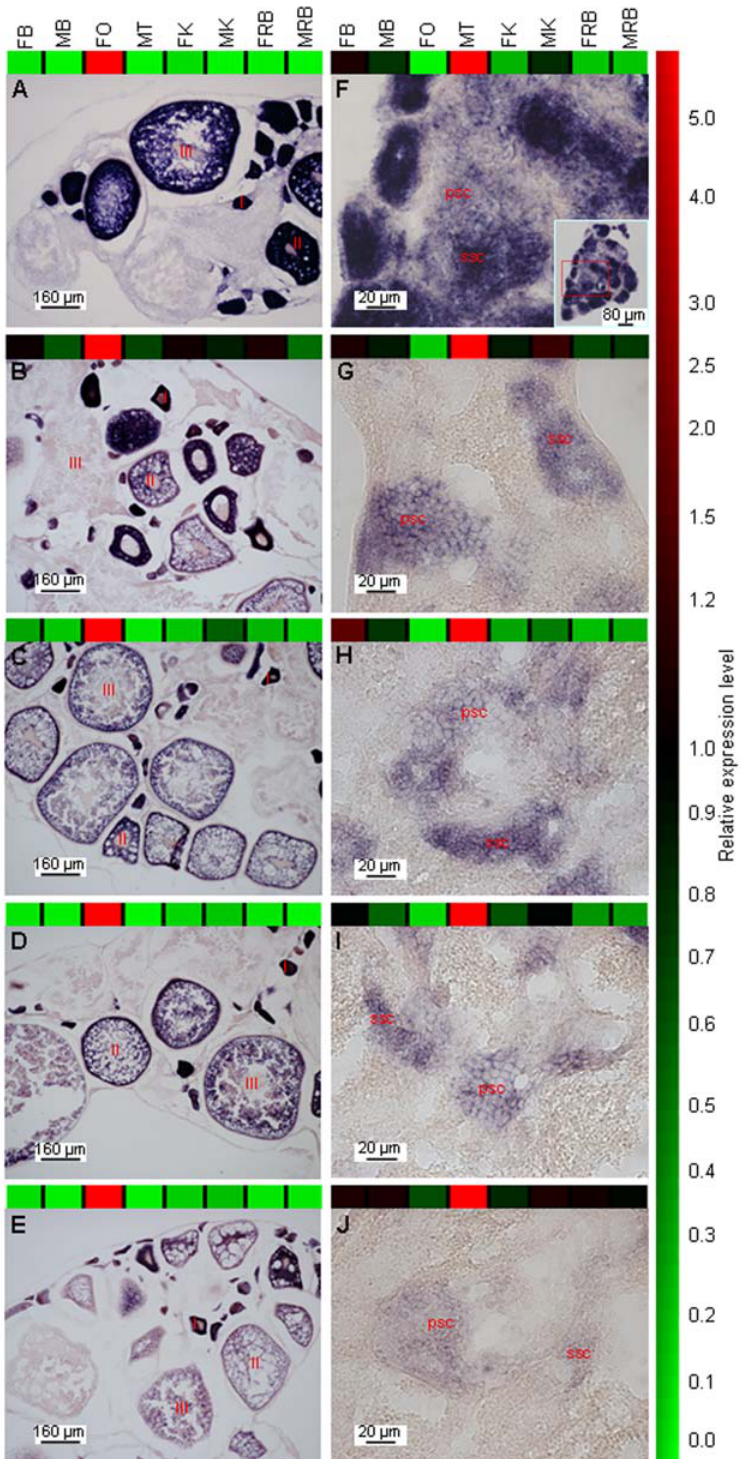
Figure 2. Insitu hybridization revealed expression in the germline for ovary- and testis-enhanced genes. Adult ovary (A–E) and adult testis (F–J) sections were hybridized with DIG-labeled riboprobes of ten genes which expressed strongly in either one of the gonads. Images are arranged from top to bottom in order of decreasing in situ hybridization signal intensity. Microarray expression levels for each gene across the eight organs analyzed are indicated by the coloured expression profiles. (A: zp2 , B: btg4 , C: CO350808, D: gez1 , E: CO350303, F: gez2 , G: sept4 , H: CO353006, I: tekt1 , J: MGC75611; I, II, III: stage I, II and III oocytes; psc: primary spermatocytes, ssc: secondary spermatocytes; FB, FO, FK and FRB represent the brain, ovary, kidney and ‘rest-of-body’ from female zebrafish, while MB, MT, MK and MRB represent the brain, testis, kidney and ‘rest-of-body’ from male zebrafish.)